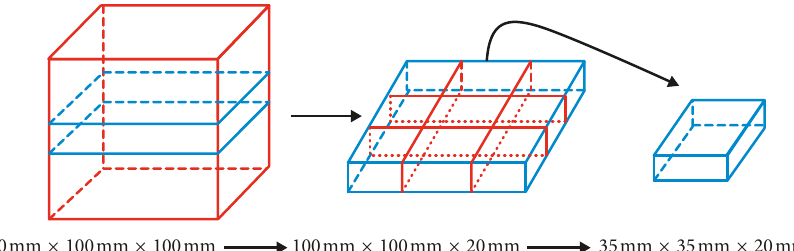
Figure 5: Cutting process of the NMR test piece.